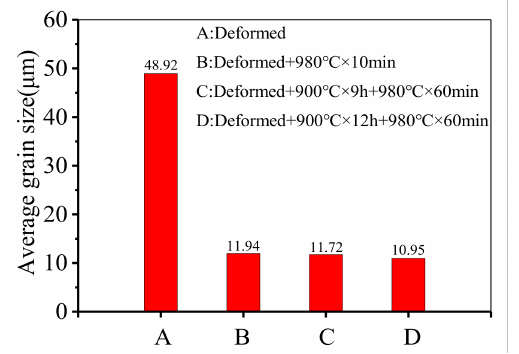
Figure 9. The average grain size after different annealing